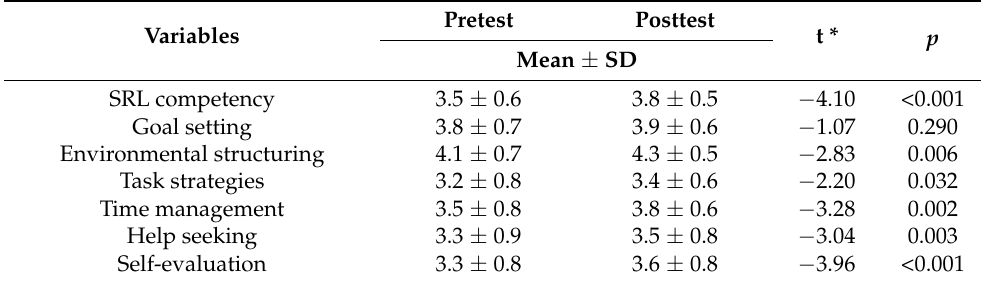
Table 3. Mean difference of SRL competency between pretest and posttest ( n =